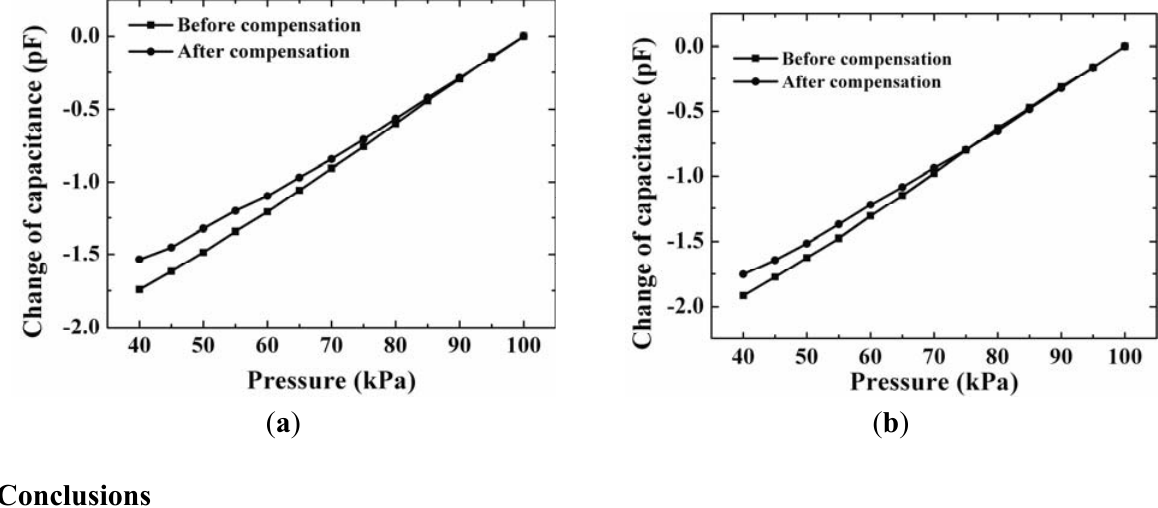
Figure 13. The capacitance-pressure characteristics before and after compensation with an Al ring: ( a ) the ring’s inside radius is 900 μ m; ( b ) the ring’s inside radius is 300 μ